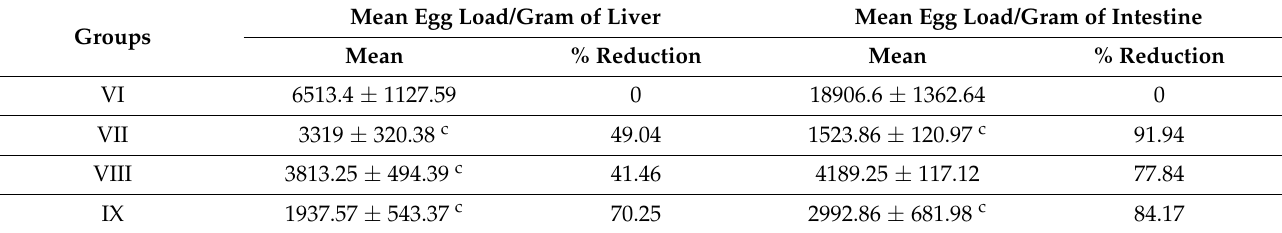
Table 2. Egg load per gram of liver and intestine of S. mansoni infected mice and reduction rate after different treatment regimens (8 weeks pi).